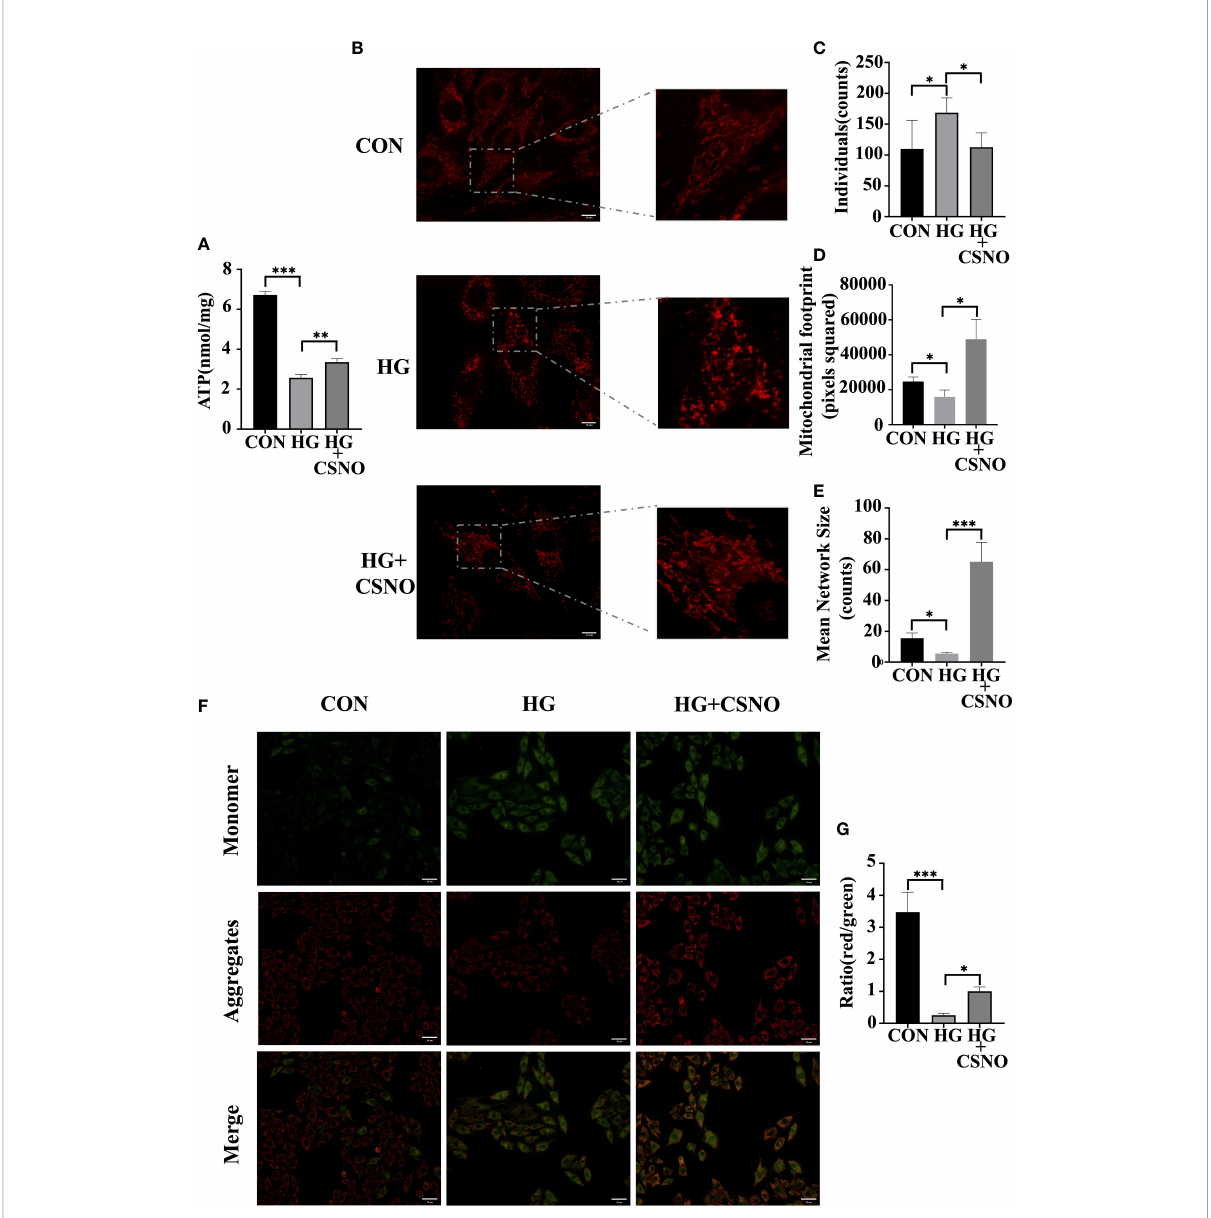
FIGURE 7 CSNO ameliorated high glucose-induced mitochondrial dysfunction. (A) ATP assay kits were used to determine cellular ATP levels. (B) Analysis of mitochondria stained with MitoTracker using confocal microscopy. Scale bar =10 m m. (C-E) MiNa in ImageJ was used to analyze the structural characteristics of the mitochondrial network, including individuals, mitochondrial footprint and mean network size. (F) Mitochondrial membrane potential (MMP) was determined by staining with JC1. JC-1 aggregates emit red fl uorescence in healthy mitochondria with polarized inner mitochondria. As MMP dissipates, cytosolic monomers of JC-1 emit green fl uorescence. Scale bar=50 m m. (G) A fl uorescence ratio of red to green was used to calculate the MMP of cardiomyocytes for each group. * represents p < 0.05; ** represents p < 0.01; *** represents p <